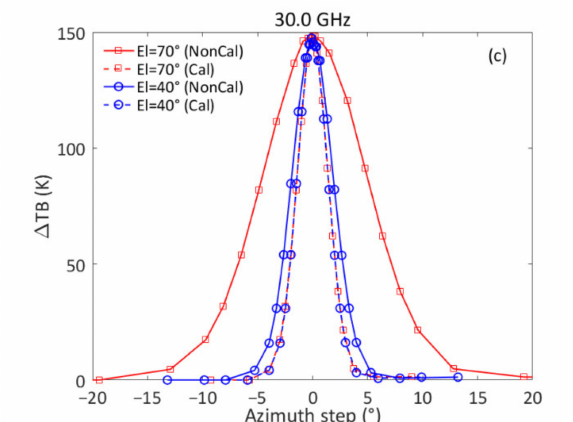
Figure 12. This is a real example of the scanning angle distortion on 18 June 2020. The azimuth distortion arises from the rotation of the antenna in the azimuth at different solar elevations (40 ◦ and 70 ◦ ). The horizontal axis is the rotation angle of the GMR antenna in the azimuth and the origin represents the center of the sun. The vertical axis is the TB increment. “NonCal” means “before distortion calibration” and “Cal” means “after distortion calibration”. ( a ) 22.235 GHz, ( b ) 26.235 GHz, and ( c ) 30.0 GHz.